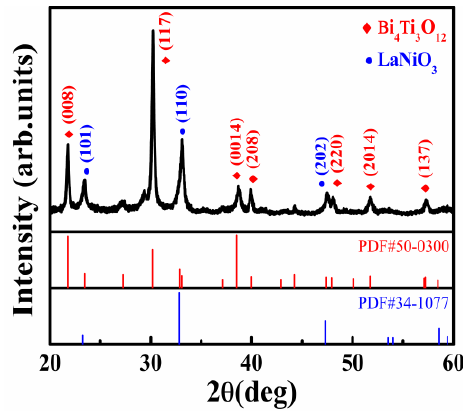
Figure 1. XRD patterns of the Au/BIT/LNO/p-Si sample.